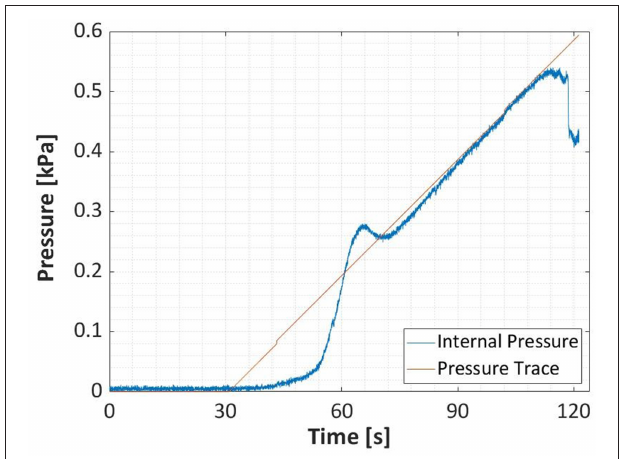
FIGURE 3 | Comparison of programmed ramping load trace (red) at 0.4 kPa/min with the chamber’s internal pressure measurements